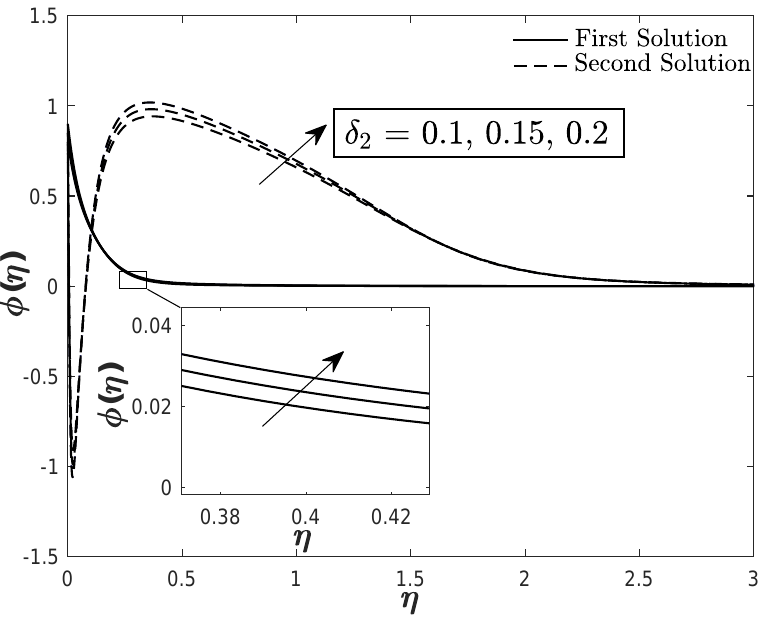
Figure 11. Effect of solutal stratification δ 2 on the concentration